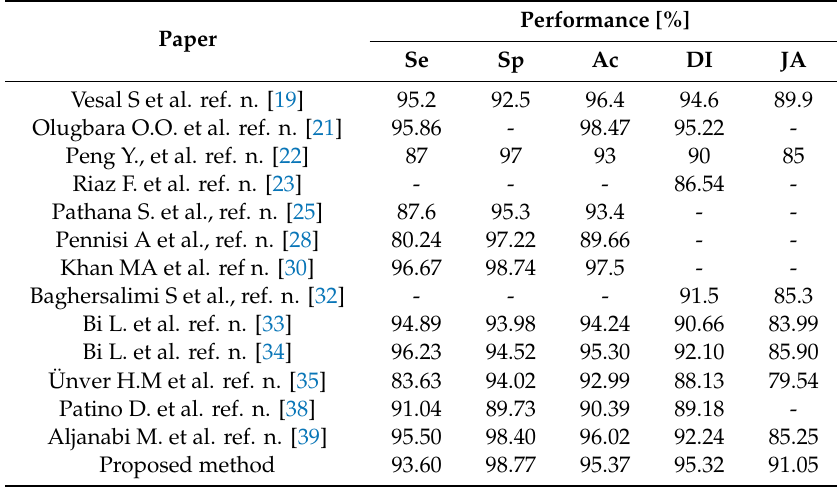
Table 1. Performance comparison among some most recent segmentation procedures indicated in literature which adopted the PH 2 database.